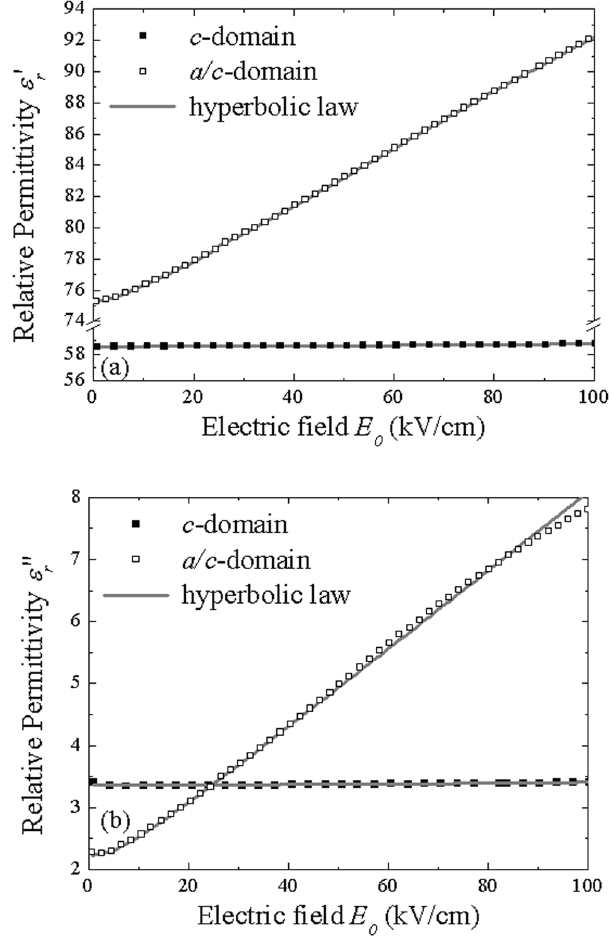
Figure 4. ( a ) Real and ( b ) imaginary part of the permittivity as a function of AC field amplitude (f = 10 kHz) for the two samples.